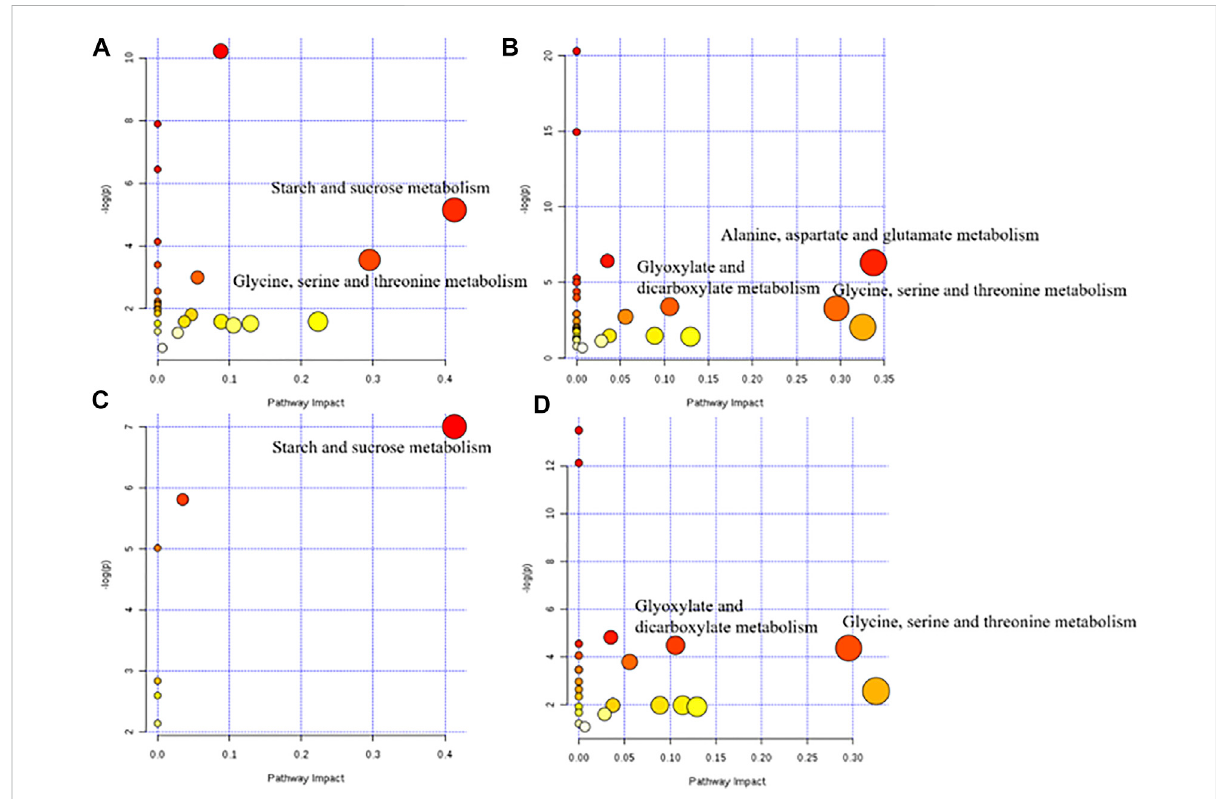
FIGURE 5 Metabolicpathwaydiagramofeachadministrationgroup. (A) HDgroupvs.Mgroup; (B) MDgroupvsMgroup; (C) LDgroupvs.Mgroup; (D) PD group vs. M group.